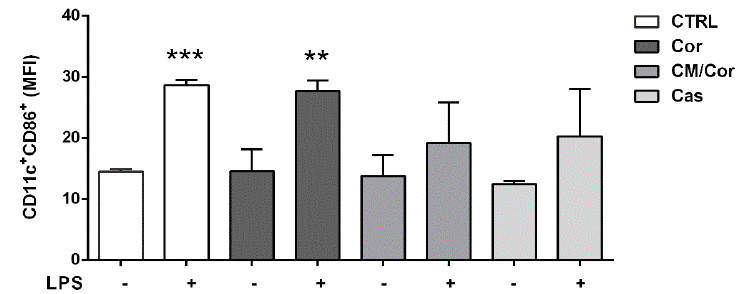
Figure 3. EVOO extracts differently modulate the expression of CD86 costimulatory molecule based on their chemical composition. The bars represent CD86 cell surface expression calculated on CD11c + gated cells at basal conditions and 24 h after LPS stimulation. Data are expressed as a mean value of Median Fluorescence Index (MFI) ± SEM ( n = 3) of untreated (Ctrl) and treated BMDCs with different EVOO extracts (12.5 µg/ml). Statistical significance was calculated for each treatment (Ctrl and Cor-CM/Cor-Cas EVOO extracts) vs. the relative unstimulated sample. ** p < 0.001, *** p < 0.0001 .